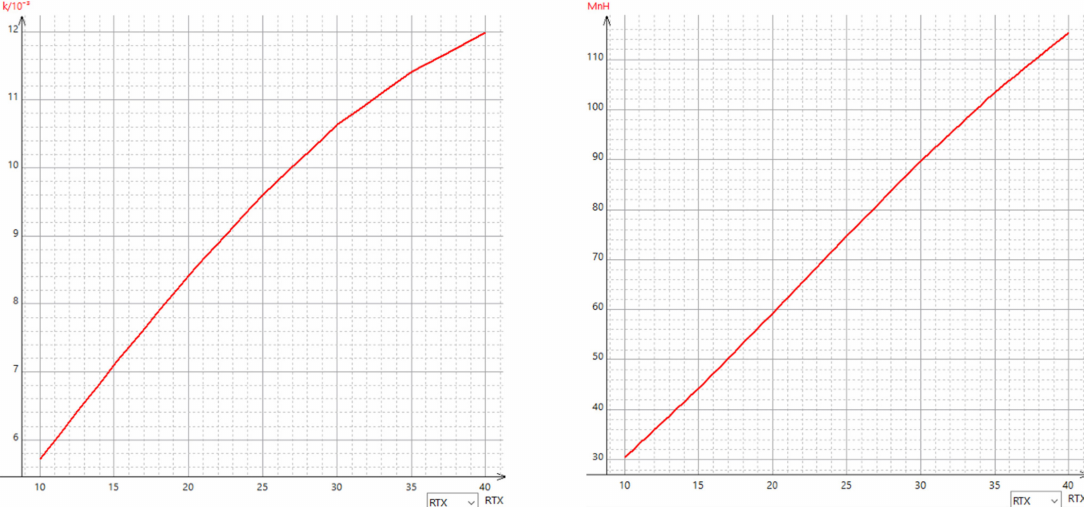
Figure 15. R TX variation simulation results of circular coil model: k in the function of R TX , M in the function of R TX